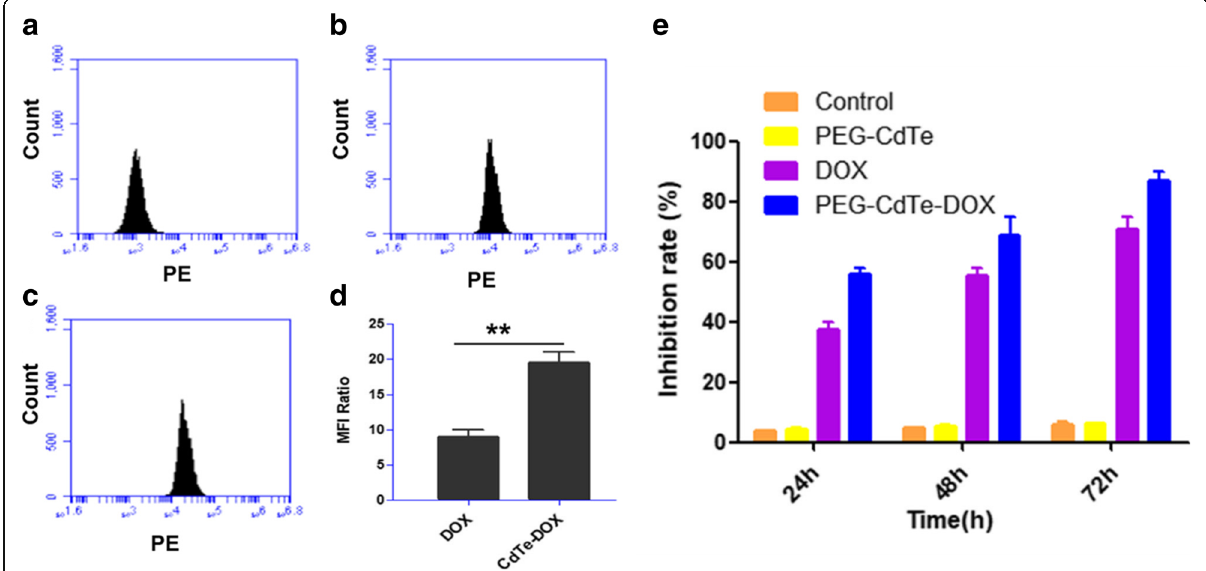
Fig. 4 Mean fluorescence intensity in PRMI8226 by flow cytometry and growth inhibition of PRMI8266 cells with different treatments. Notes: a PEG-CdTe; b DOX; c PEG-CdTe-DOX; d the fluorescence intensity of DOX and PEG-CdTe-DOX compared to PEG-CdTe (** P < 0.01). e CCK-8 analysis of PRMI 8226 cells treated with PBS (control), PEG-CdTe, DOX, and PEG-CdTe-DOX at 24, 48, and 72 h (* P <